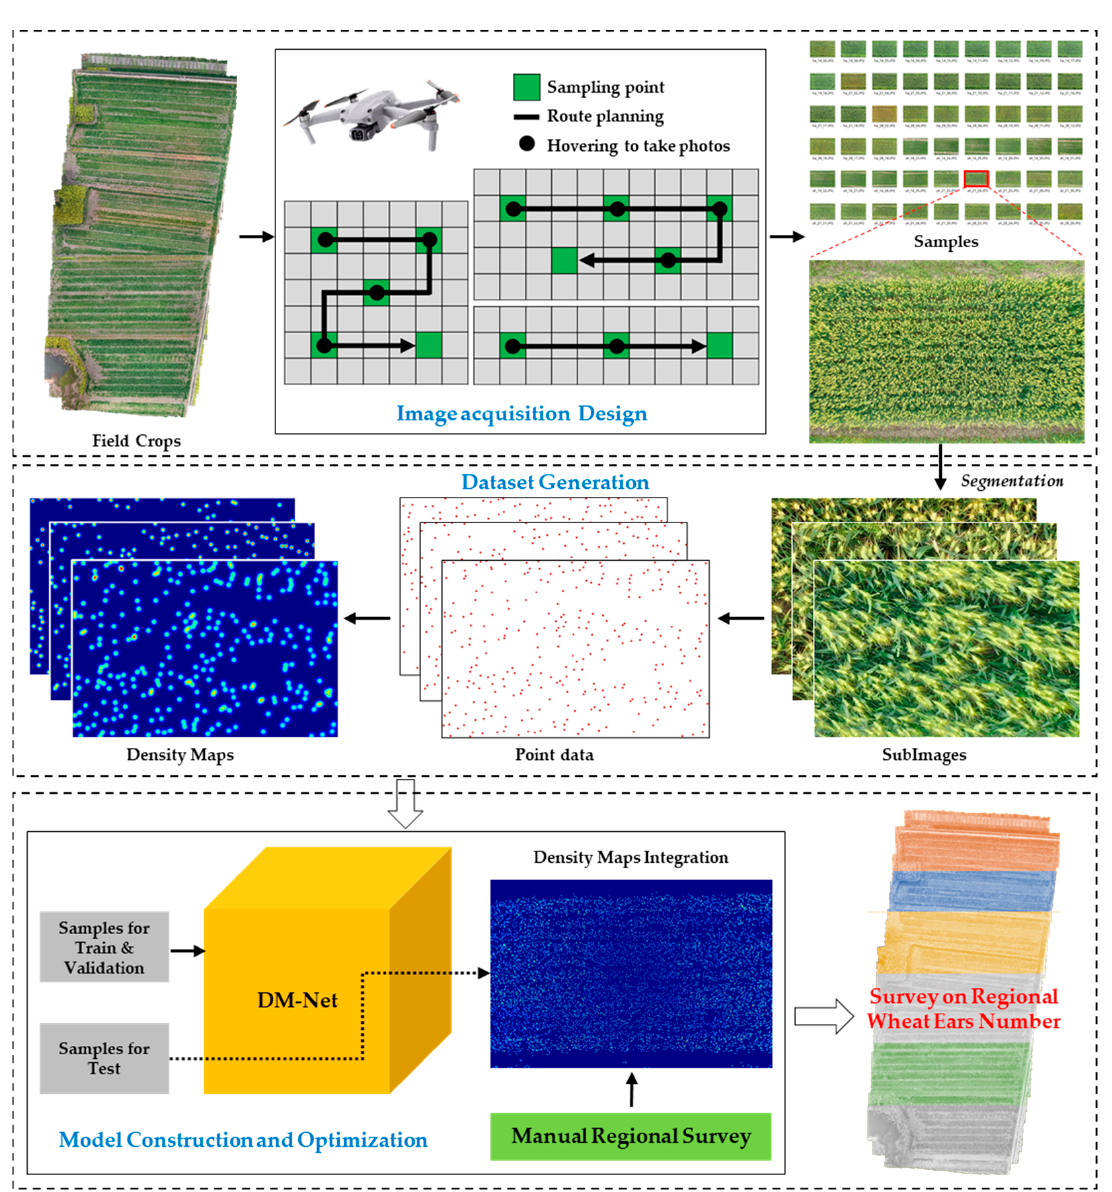
Figure 2. UAV-based sampling survey pipeline of wheat ear numbers.